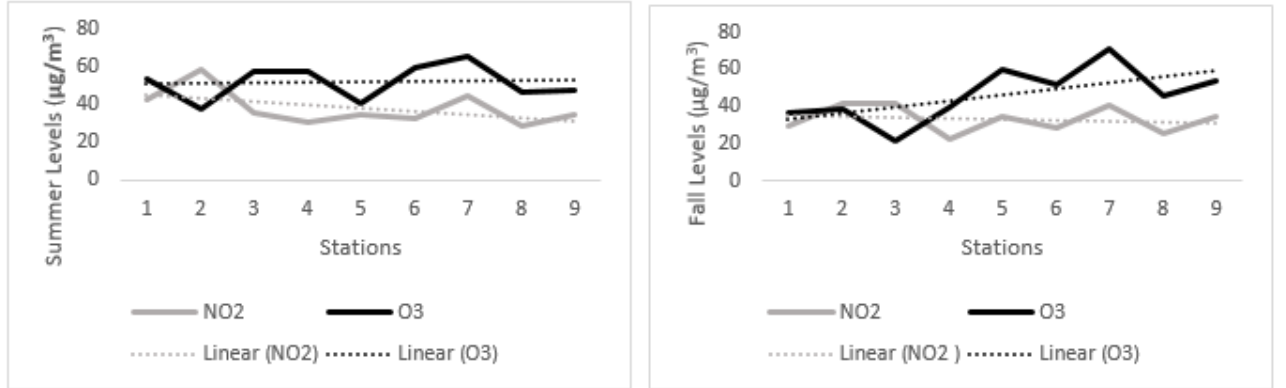
Figure 5. O 3 concentration for fall and summer 2019 at study locations.